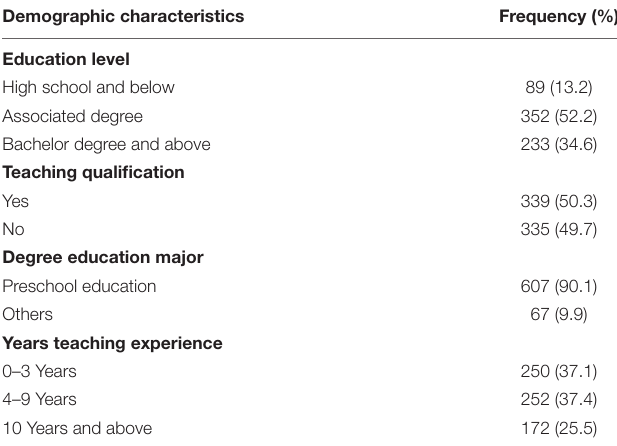
TABLE 1 | Participant characteristics ( N = 674). TABLE 2 | Structure and loadings of CTPBS for principal component analysis with varimax/promax